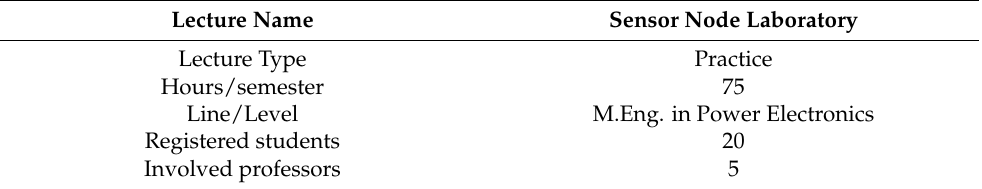
Table 2. Official information of the lecture.